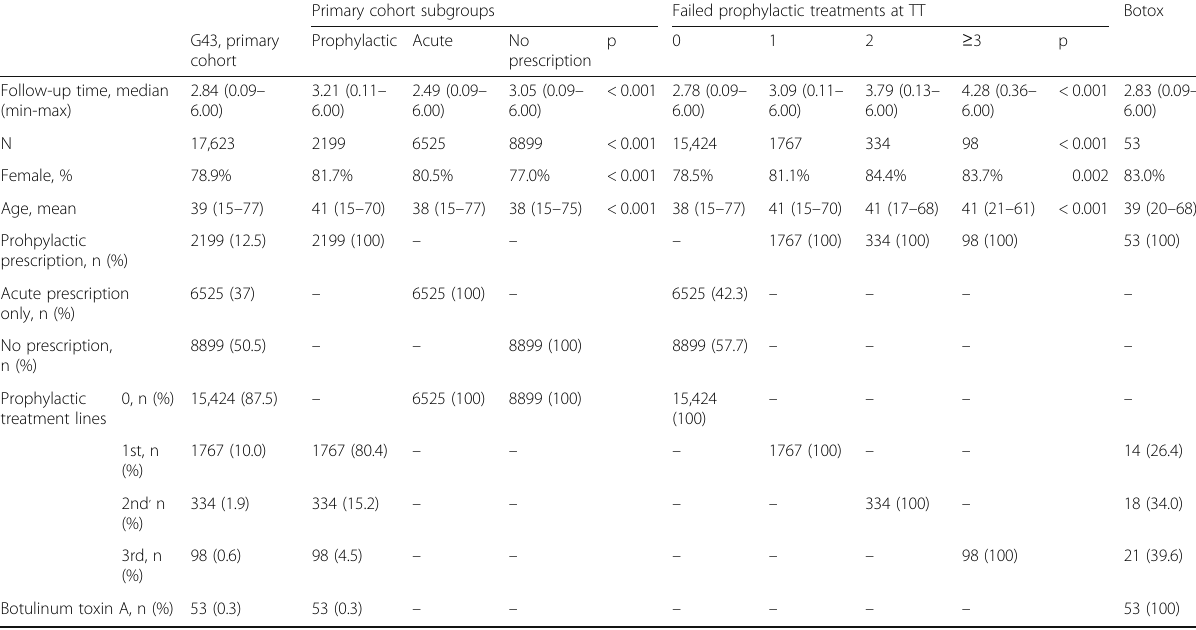
Table 1 Baseline characteristics of consented patients with migraine in the occupational health care register Primary cohort subgroups Failed prophylactic treatments at TT Botox G43, primary Prophylactic Acute No cohort prescription